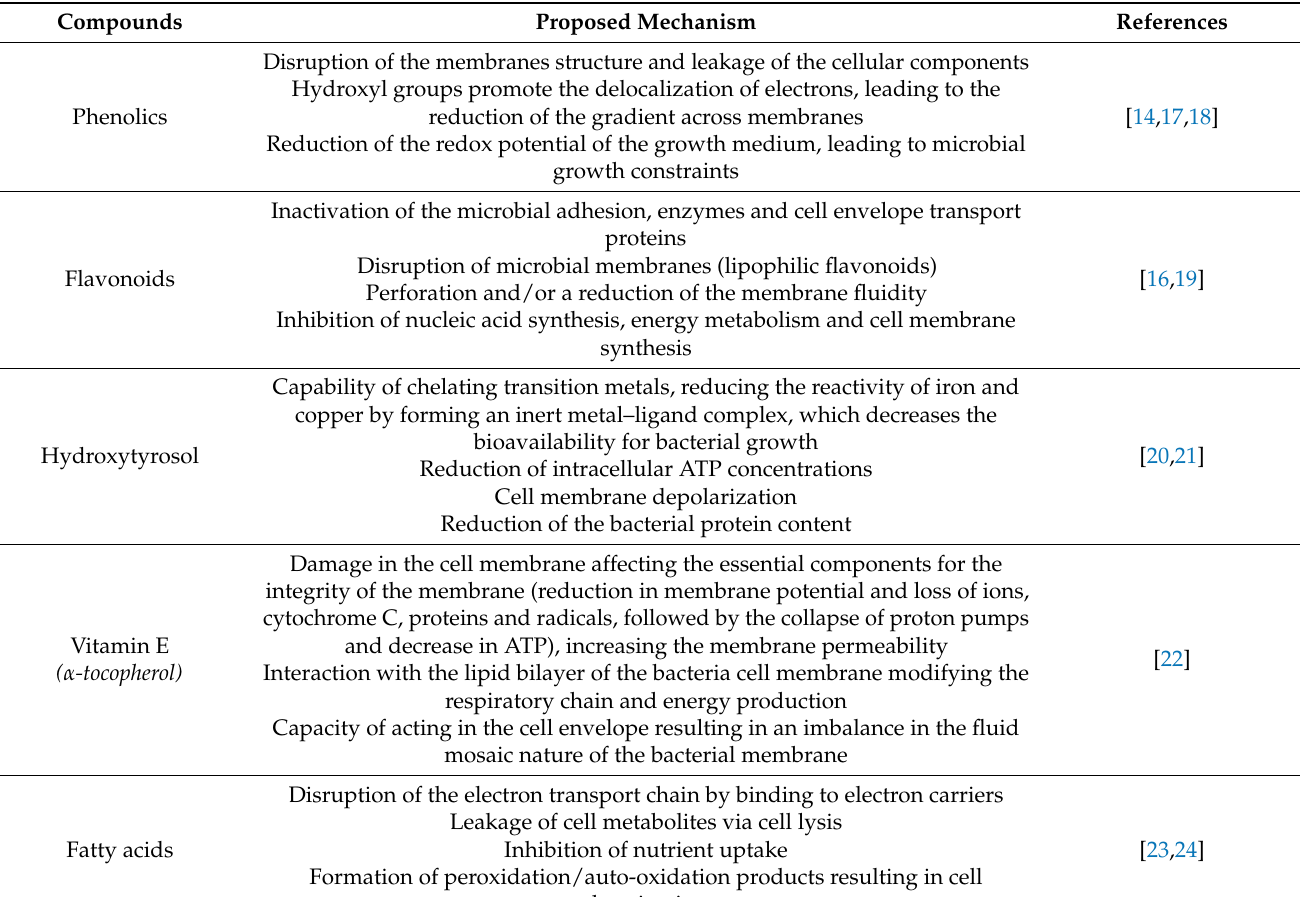
Table 6. Olive pomace bioactive compounds and proposed mechanisms of